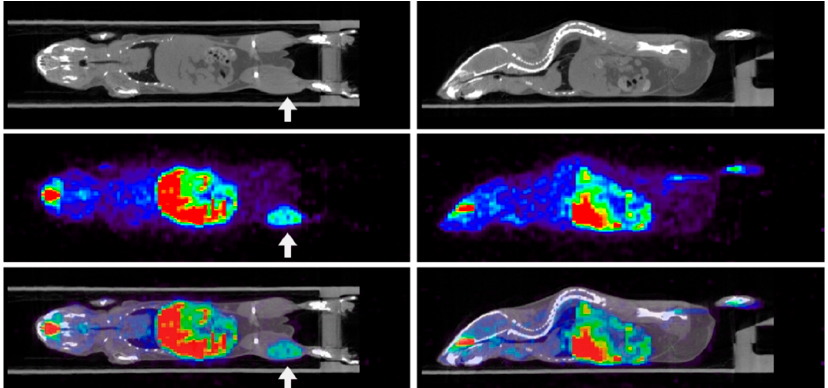
Figure 2. Whole body distribution of 64 Cu-ATSM. Coronal (left 3 panels) and sagittal (right 3 panels) whole body scans of a SCCVII tumor-bearing mouse. Top, center, and bottom images show X-ray CT image, 64Cu-ATSM PET image; fused 64 Cu-ATSM/CT image, respectively. Uptake of 64 Cu-ATSM was obtained in the tumor-bearing leg (upper arrow in coronal images), abdomen (liver and duodenum intestine), and head region of the animals. The figures were partly modified from our previous reports [52].